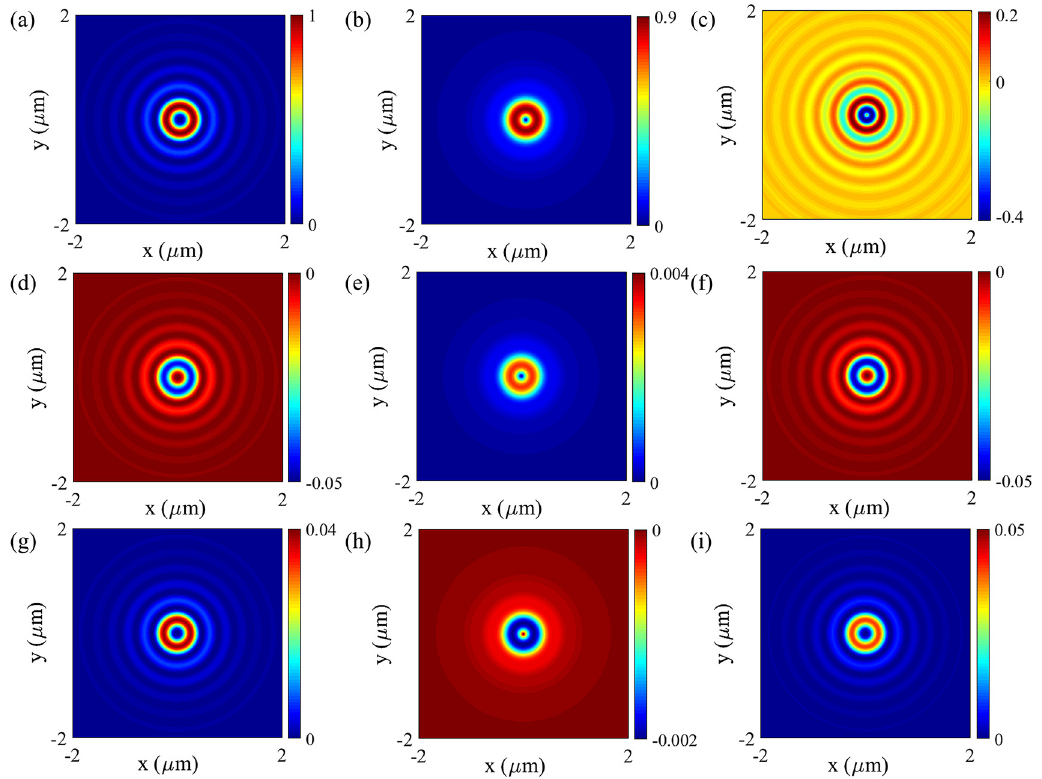
Figure2: Energyflowdensity(EFD),orbitalandspinflowdensitiesof p -polarizedBessel-typesurfacemodewithtopologicalcharge l = + 2.The azimuthal EFD (a), orbital fl ow density (OFD) (b) and spin fl ow density (SFD (c) of surface mode in the upper half-space (at z = 10 nm) as the relativepermittivityandpermeabilityare1;theazimuthalEFD(d),OFD(e)andSFD(f)ofsurfacemodeinthelowerhalf-space(at z = − 10nm)as the relative permittivity and permeability are respectively − 11.8 and 1; the azimuthal EFD (g), OFD (h) and SFD (i) of surface mode in the lower half-space (at z = − 10 nm) as the relative permittivity and permeability are respectively 11.8 and − 1.5. The EFD is determined by the sgn( l / ε ), whiletheOFDisrelatedtothesgn( l / μ ).Thewavelengthis633nm.Allquantitiesarenormalizedtothemaximalabsolutevalueofenergy fl owin the upper